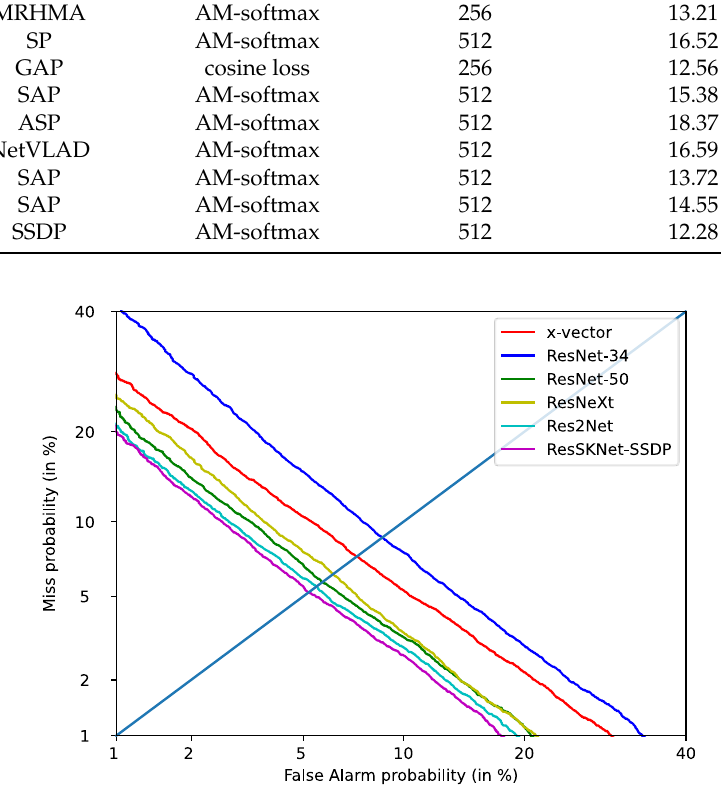
Figure 6. DET curve of systems on CN-celeb.